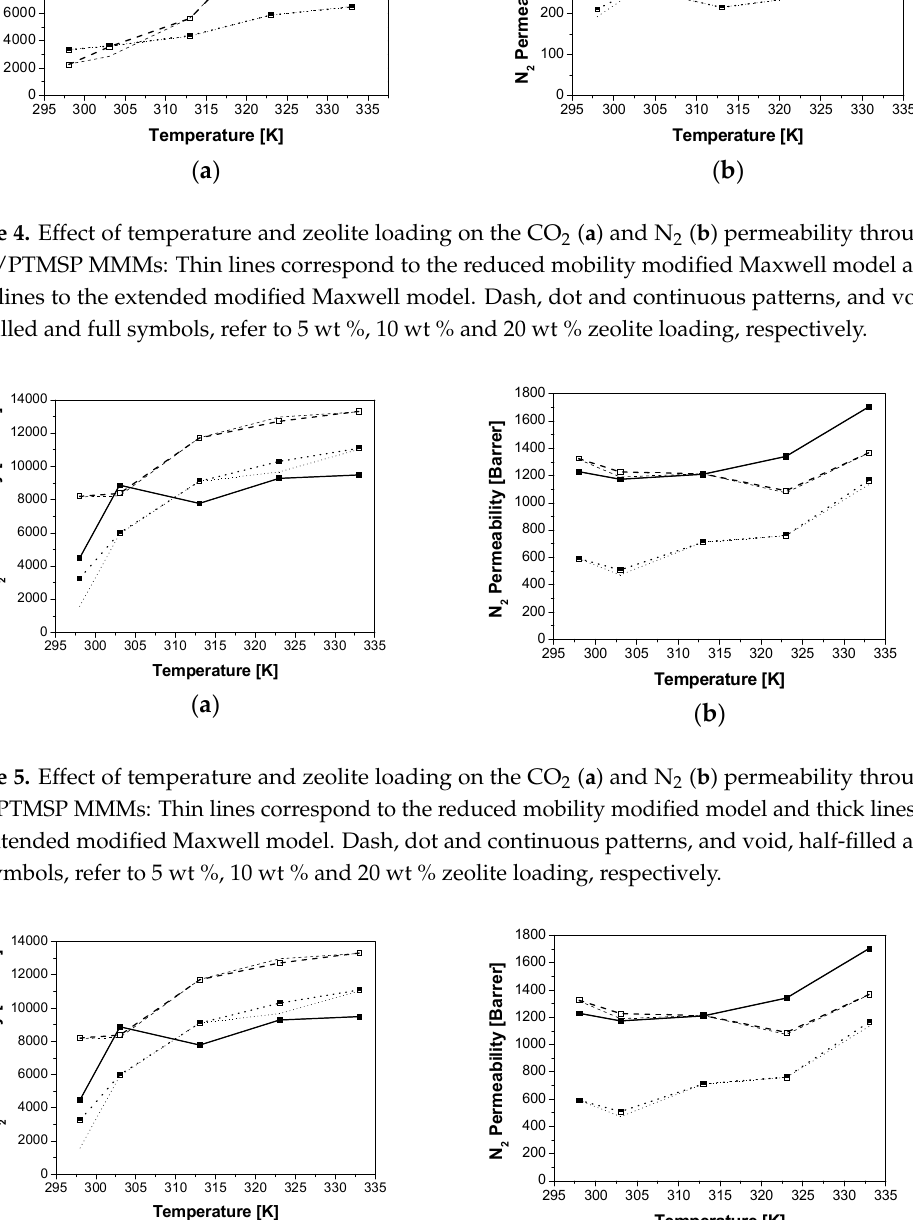
Figure 6. Effect of temperature and zeolite loading on the CO 2 ( a ) and N 2 ( b ) permeability through RHO/PTMSP MMMs: Thin lines correspond to the reduced mobility modified model and thick lines to the extended modified Maxwell model. Dash, dot and continuous patterns, and void, half-filled and full symbols, refer to 5 wt %, 10 wt % and 20 wt % zeolite loading, respectively.